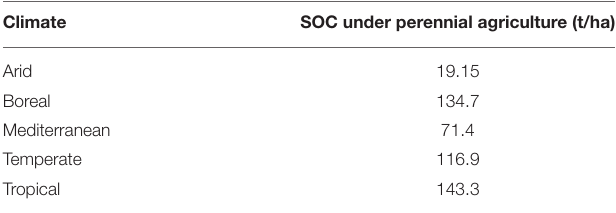
TABLE 1 | Soil organic carbon estimates for perennial crops in different climatic regions. Climate